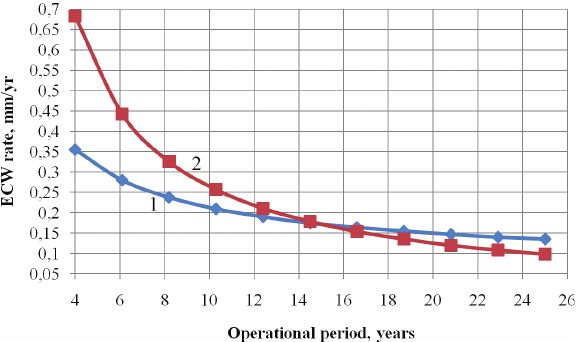
Figure 8. Values of the ECW rate in the steam line accord- ing to measurements and calculations using EKI-03: 1 –